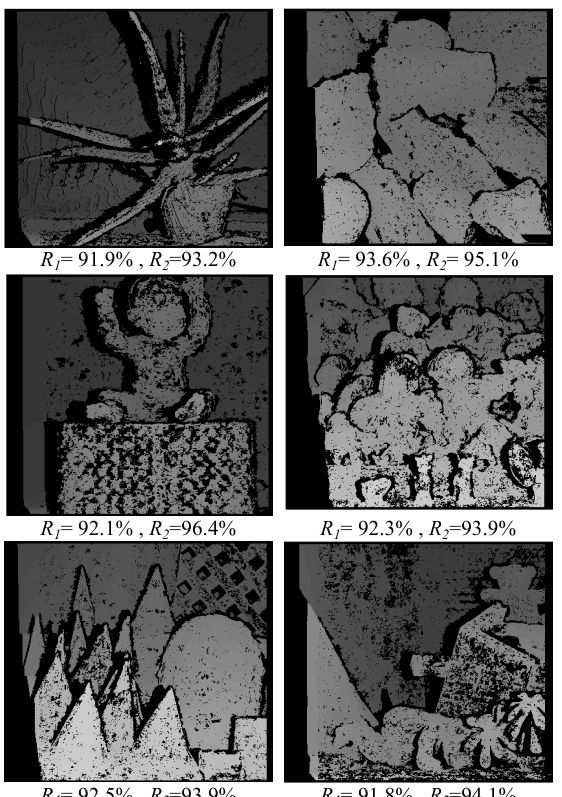
Figure 8. Estimated disparity maps using the proposed matching technique and their